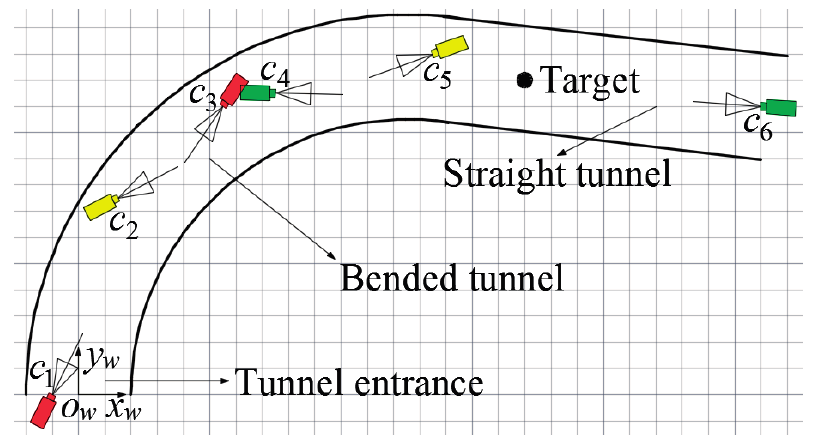
Figure 11. Topology of the experiment.